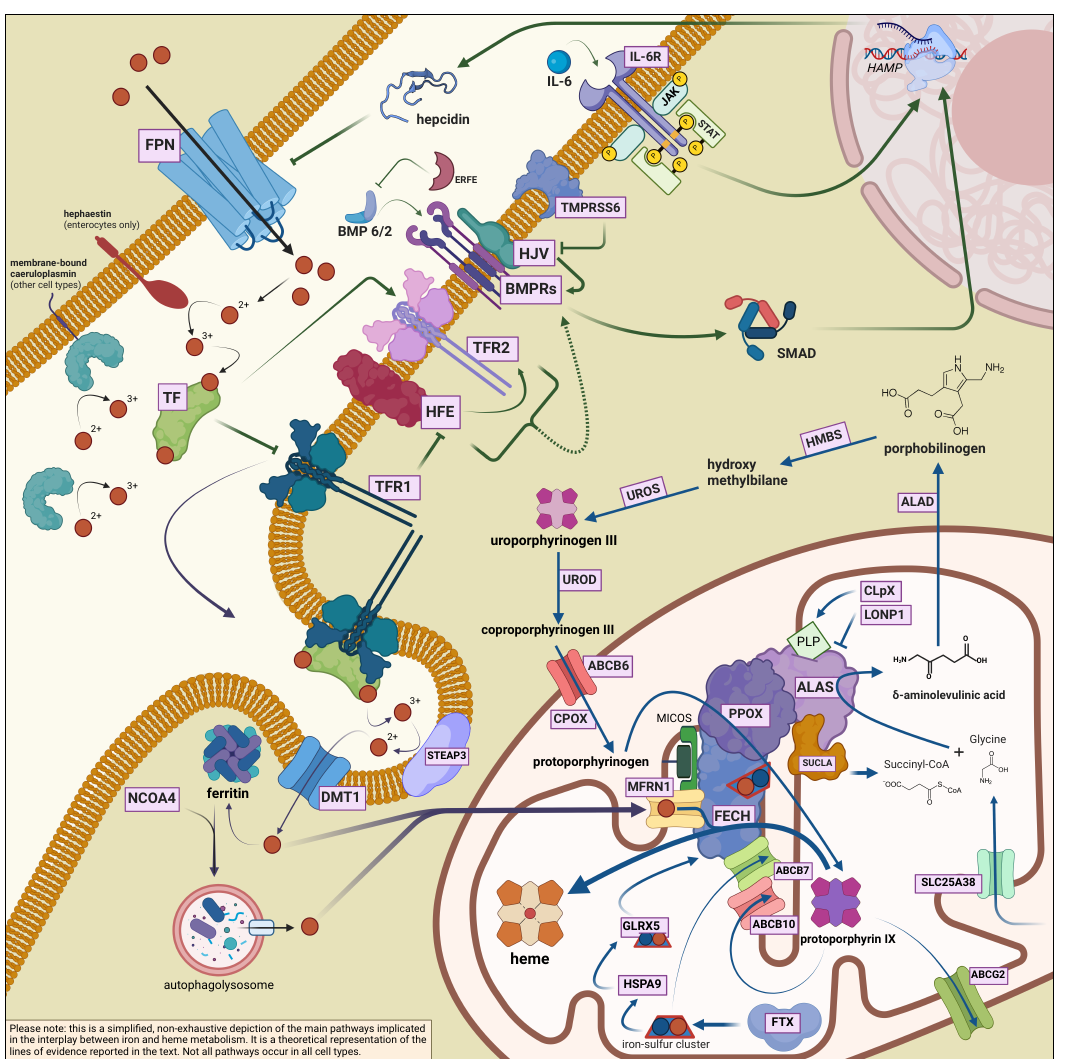
Figure 1. From iron to heme. Both iron metabolism and heme biosynthesis are complexly regulated to efficiently exploit the properties of iron in the most diverse biochemical settings. The mechanisms and factors depicted are described in detail in Section 2. ALAD, δ -aminolaevulinate dehydratase; ALAS, δ -aminolaevulinate-synthase; ABCB6, ATP-binding cassette super-family B member 6; ABCB7, ATP- binding cassette super-family B member 7; ABCB10, ATP-binding cassette super-family B member 10; ABCG2, ATP-binding cassette superfamily G member 2; BMP 6/2, bone morphogenetic protein 6 and 2 dimer; BMPRs, bone morphogenetic protein receptors; CLpX, caseinolytic mitochondrial matrix peptidase chaperone subunit X; CPOX, coproporphyrinogen III oxidase; DMT1, divalent metal transporter 1; ERFE, erythroferrone; FECH, ferrochelatase; FPN, ferroportin; FTX, frataxin; GLRX5, glutaredoxin 5; HAMP , hepcidin gene; HFE, human homeostatic iron regulator protein; HJV, hemojuvelin; HMBS, hydroxymethyl- bilane synthase; HSPA9, heat-shock protein family A member 9; IL-6, interleukin 6; IL-6R, interleukin 6 receptor; JAK, Janus kinase; LONP1, lon peptidase 1, mitochondrial; MICOS, mitochondrial contact site and cristae organizing system; MFRN1, mitoferrin 1; NCOA4, nuclear receptor coactivator 4; PLP, pyridoxal phosphate; PPOX, protoporphyrinogen oxidase; SLC25A38, mitochondrial solute carrier family member 25 A38 (glycine transporter); SMAD, small mother against decapentaplegic (protein family); STAT, signal transducer and activator of transcription protein; STEAP3, the six-transmembrane epithelial antigen of prostate 3 (metalloreductase); SUCLA, succinyl-CoA synthase; TF, transferrin; TFR1, transferrin receptor 1; TFR2, transferrin receptor 2; TMPRSS6, matriptase; UROD, uroporphyrinogen III decarboxylase; UROS, uroporphyrinogen III synthase. The red circles represent iron atoms; when needed, ferrous ( 2+ ) or ferric ( 3+ ) states are indicated. Created with Biorender.com (last accessed on 25 August